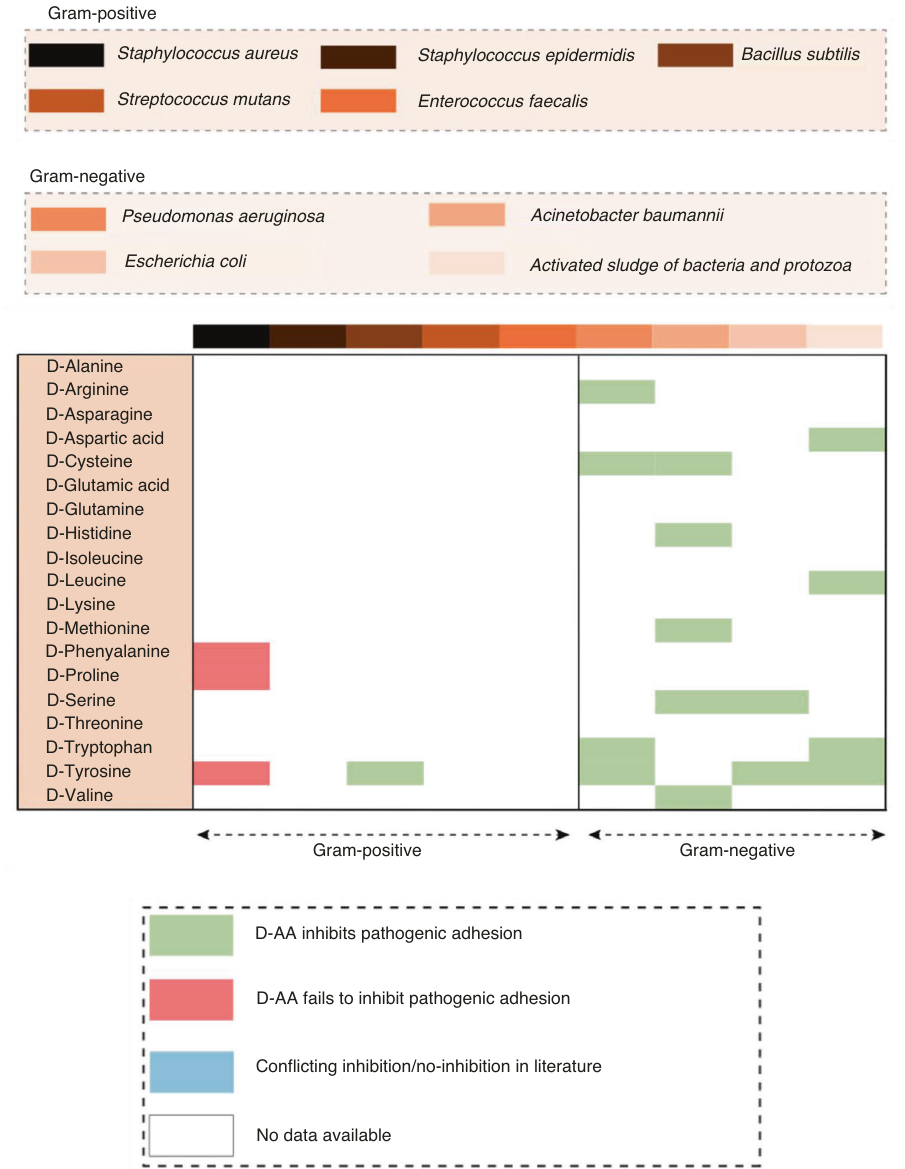
Fig. 3 A comparative heatmap of data compiled from the literature showing the various gram-positive and gram-negative microorganisms associated with PJI and the ef fi cacy of D-AAs to inhibit pathogenic bacterial adhesion to an abiotic surface. Based on the D-AAs examined thus far, studies suggest a bene fi cial role. There has been a dominant focus on exploring the effects of D-AAs on glass or polypropylene surfaces. Future studies that examine the response of pathogenic bacteria to D-AAs when exposed to orthopedic-related materials, e.g., medical grade titanium alloy, ceramics, polyetheretherketone, and highly crosslinked polyethylene, are warranted. Furthermore, to date, few studies have investigated the effect of D-AAs on many of the gram-positive species associated with